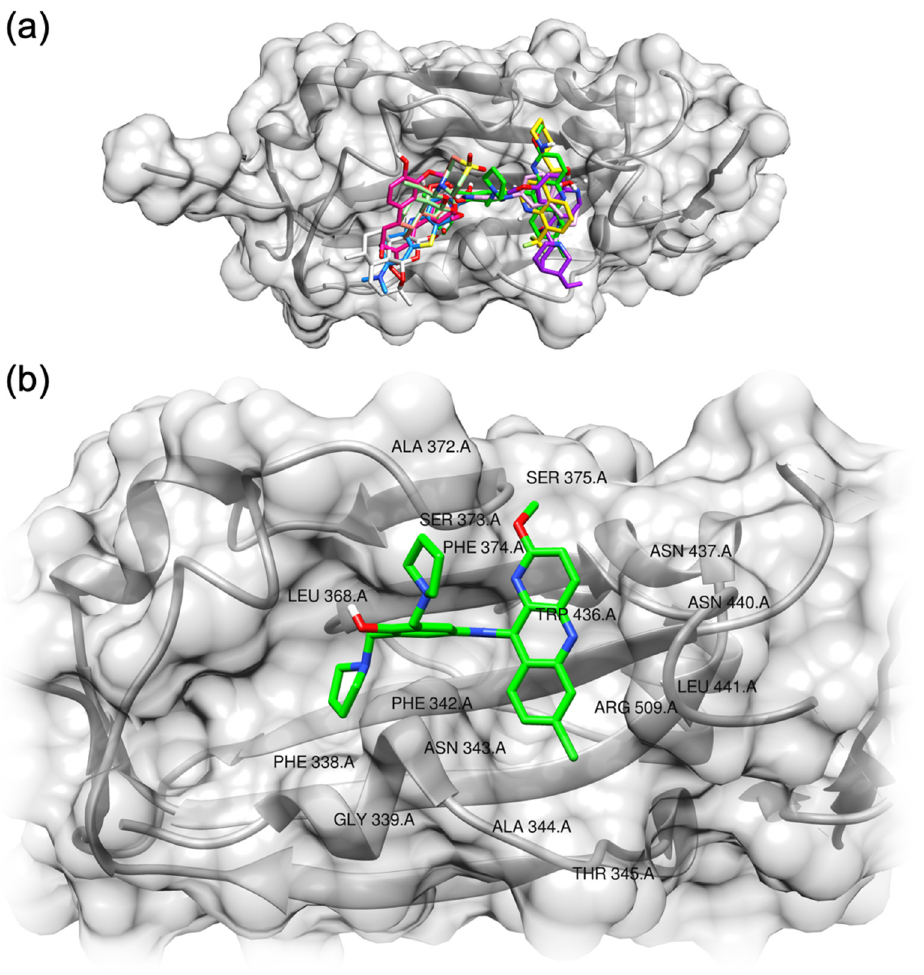
Figure 3. ( a ) Predicted binding motif for the compounds with RBD; ( b ) detailed view of the residues interacting with pyronaridine.